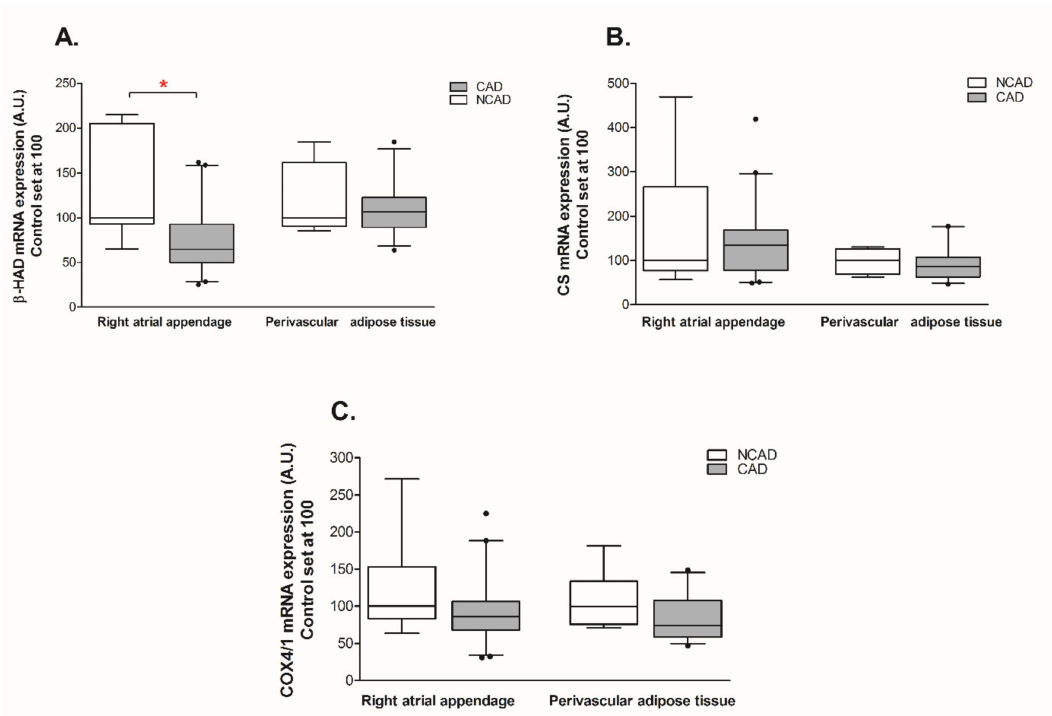
Figure 3. Myocardial and perivascular adipose tissue genes expression of ( A ) beta-hydroxyacyl CoA dehydrogenase ( β -HAD), ( B ) citrate synthase (CS), ( C ) cytochrome c oxidase subunit IV isoform 1 (COX4 / 1) in the coronary atherosclerosis (CAD, n = 42) and control (NCAD, n = 11) patients. The inner horizontal line of a box represents the median. Box boundaries: 25–75 percentile; whiskers 5–95 percentile. Data are expressed as median ± SEM. For the sake of clarity, the control group median was set at 100, and the CAD group was scaled with respect to NCAD. * p < 0.05 vs. control